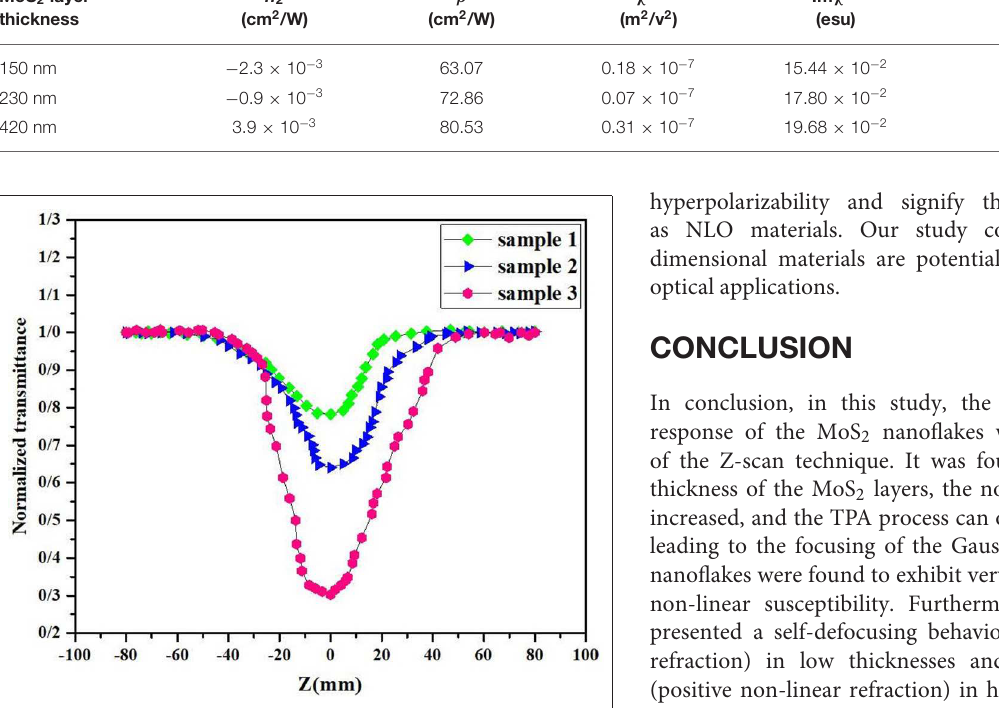
results of the experiments are used to calculate the third-order susceptibility of the MoS 2 layers with different thicknesses. The results of these calculations are also presented in Table 1